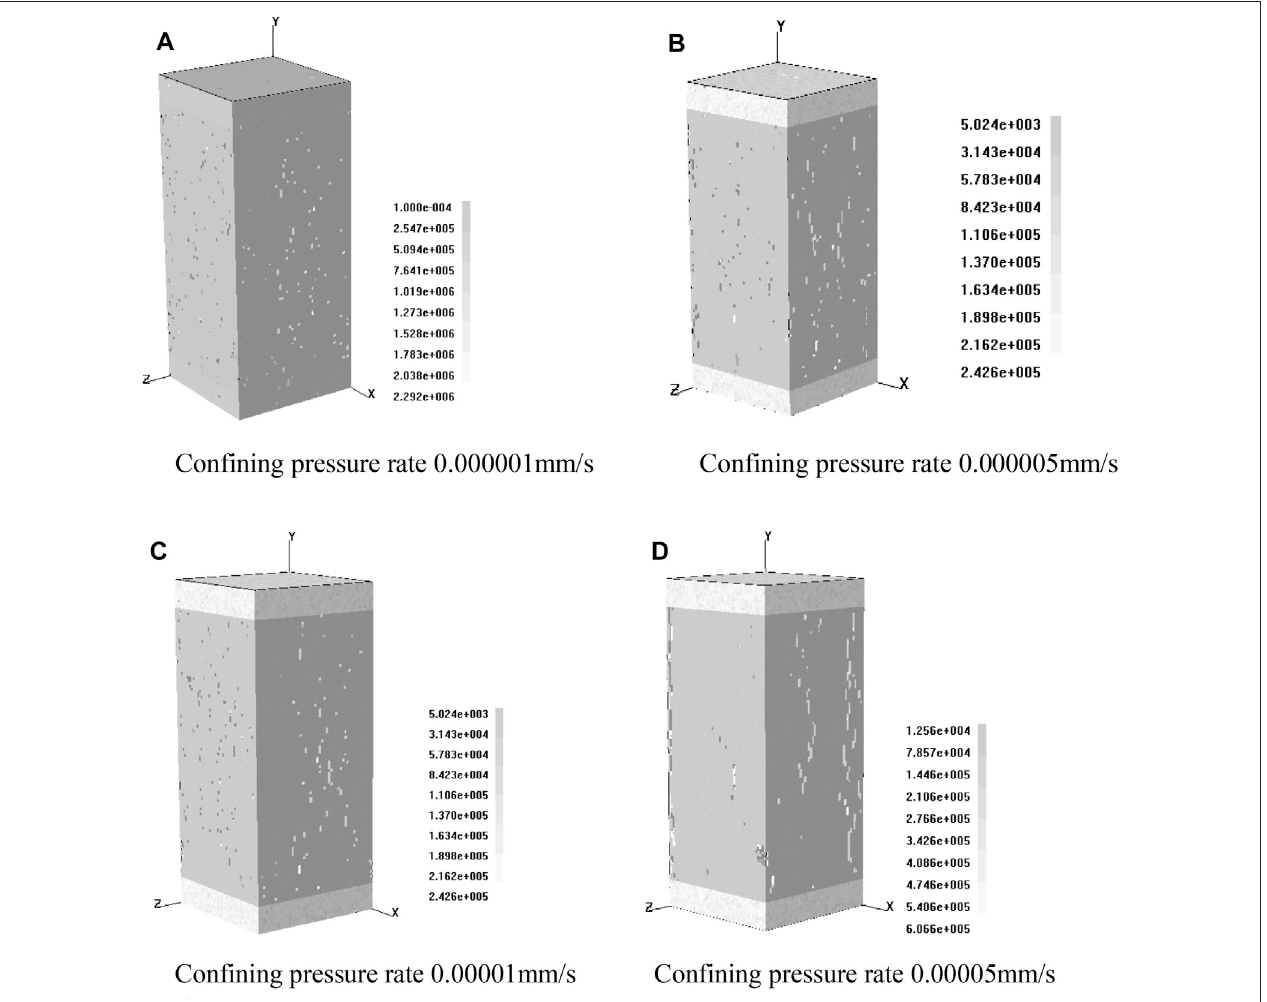
FIGURE 7 | Failure modes of rock specimens under different con fi ning pressures at 400 calculation steps. (A) is the calculation result of 400 steps on the model whenthecon fi ningpressurerateis0.000001 mm/s. (B) isthecalculationresultof400stepsonthemodelwhenthecon fi ningpressurerateis0.000005 mm/s. (C) isthe calculationresultof400stepsonthemodelwhenthecon fi ningpressurerateis0.00001 mm/s. (D) isthecalculationresultof400stepsonthemodelwhenthecon fi ning pressure rate is 0.00005 mm/s.